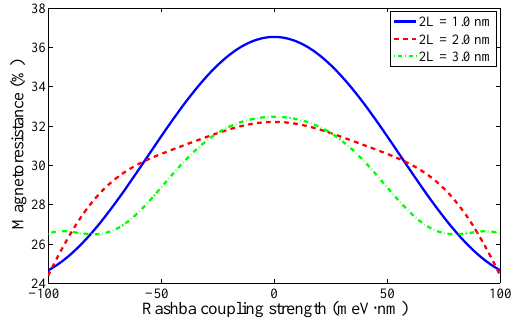
Fig. 3. Plot of the magnetoresistance as a function of Rashba spin-orbit coupling strength for different values of domain walls distances in the anti-parallel configuration of magnetization at the